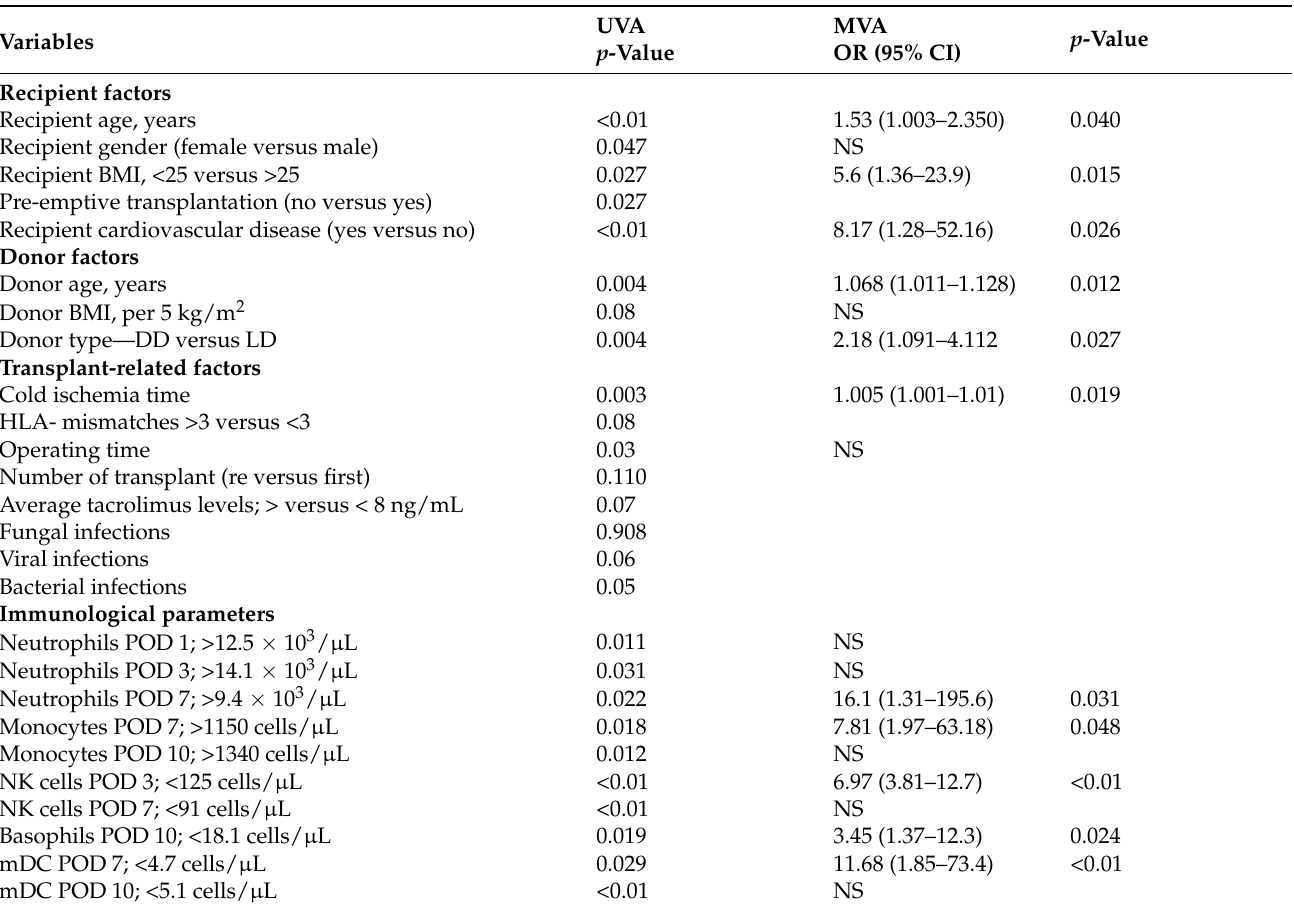
Table 4. Uni- and multivariate logistic regression analysis of clinical and immunological predictors for early renal graft injury (eRGI) after kidney